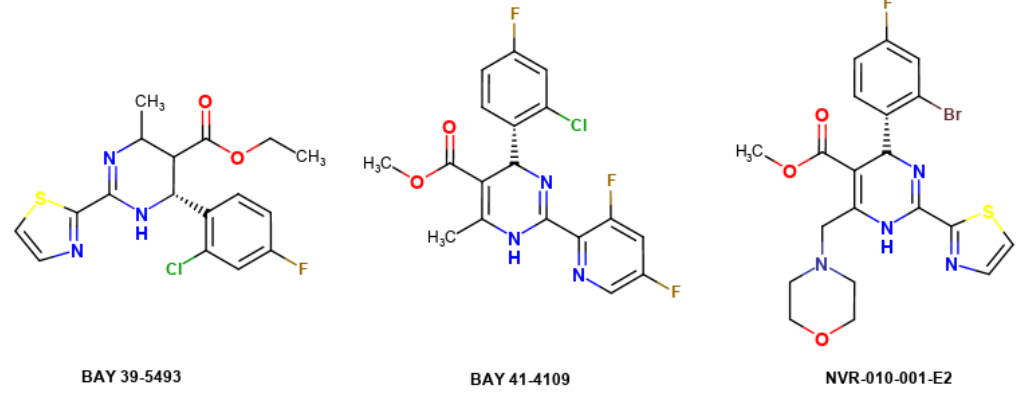
Figure 1. Heteroaryl dihydropyrimidines as the HBV inhibitors.